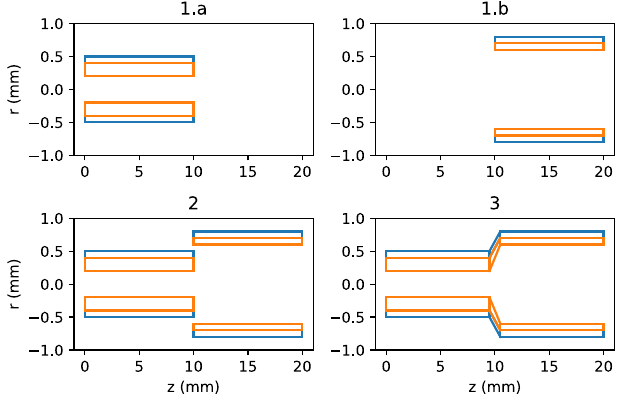
FIG. 11. Illustration of the DLW geometry used in the ECHO 2 D simulations. All cases include a (lossless) metal coating of 100 μ m thickness. The blue lines correspond to the outline of the metal coating and the orange lines to the outline of the dielectric. (1.a) Single segment of length l 1 ¼ 10 mm. (1.b) Single segment of length l 2 ¼ 10 mm. (2) Segments right next to each other (sharp, unrealistic transition). (3) Two segments connected with a linearly tapered transition region of length l t ¼ 1 mm.